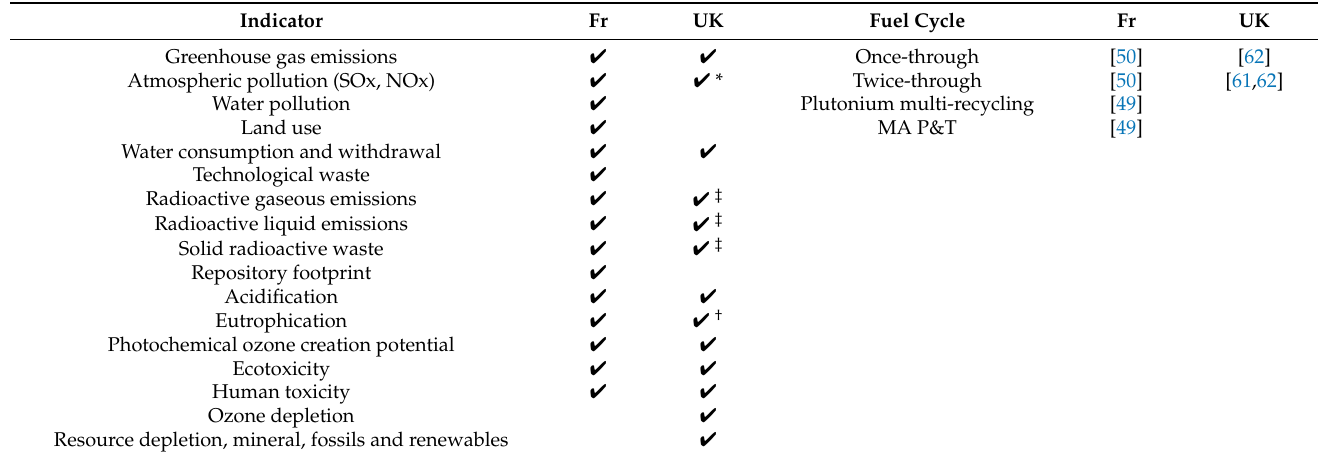
Table 6. Comparison of French and UK LCA